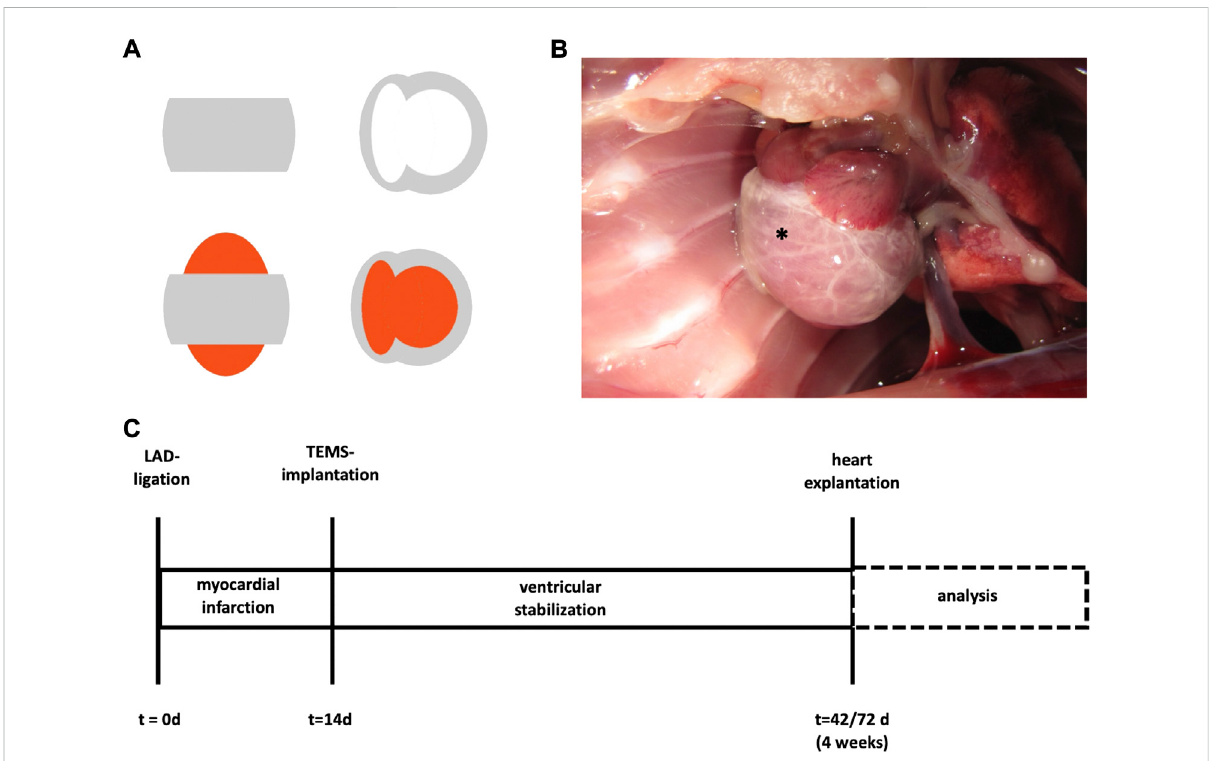
FIGURE 1 TEMSschematicsandtimelinesurgicalprotocol. (A) SchematicsofventricularstabilizationviaTEMS.Grey,cdECMscaffold;red,nativeheart. (B) MacroscopicimageofventricularstabilizationviaTEMSinrodentmodel.*,TEMS. (C) MyocardialinfarctionwasinducedbyLAD-ligationinastandard rodent model and after 14 days ventricular stabilization via TEMS implantation was performed. Hearts were explanted and analyzed after 4 or 8 weeks. LAD, left anterior descending; TEMS, tissue engineered myocardial sleeve.